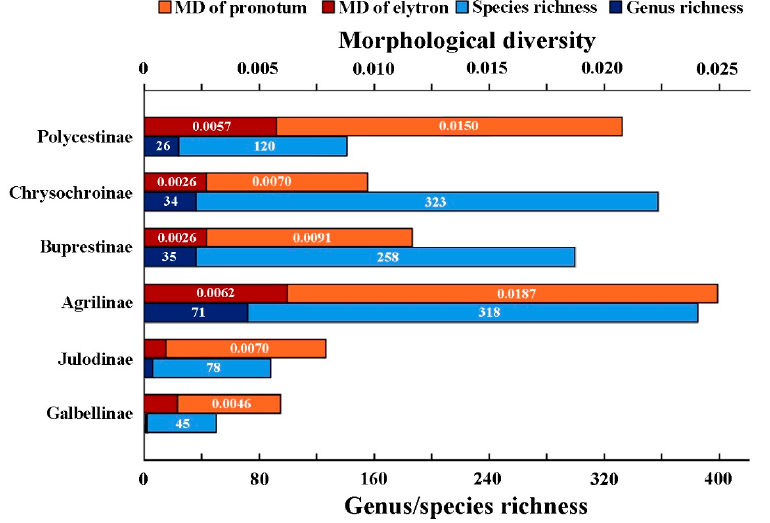
Figure 4. The morphological diversity and species/genus richness among subfamilies. The orange and crimson column represent the morphological diversity of the elytron and pronotum, the “MD” = morphological diversity; the bright and dark blue column represent the genus richness and species richness of each test subfamily,